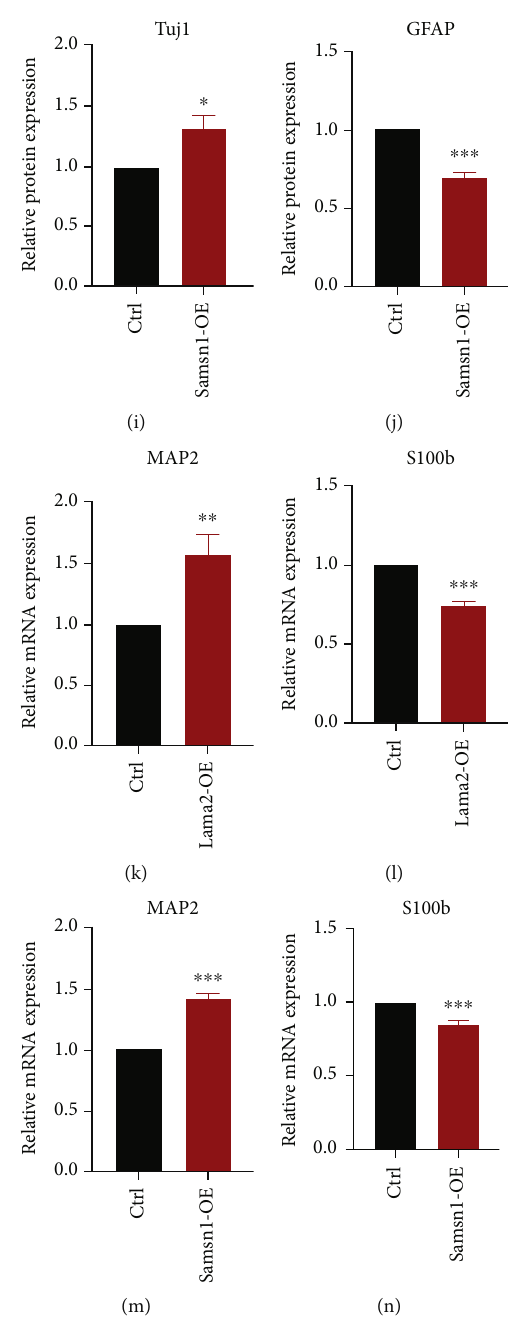
Figure 6: Lama2 activation or Samsn1 overexpression promotes NSCs di ff erentiation into neurons. (a, b) Representative immunostaining for Tuj1 (red) in the primary hippocampal NSCs after induced di ff erentiation for 7 days following plasmid transfection or lentivirus infection. Bar = 50 μ m . (c, d) Quanti fi cation of Tuj1-positive cells normalized to Hoechst. (e – j) Representative immunoblots of Tuj1, GFAP, and β -actin in the primary hippocampal NSCs after induced di ff erentiation for 7 days following plasmid transfection or lentivirus infection (e, f) and quanti fi cation of Tuj1 and GFAP protein levels normalized to β -actin (g – j). (k – n) Quanti fi cation of MAP2 and S100b mRNA levels normalized to β -actin after induced di ff erentiation for 7 days following plasmid transfection or lentivirus infection. Error bars represent the mean ± SEM . n = 3 . ∗ P < 0 : 05 , ∗∗ P < 0 : 01 , ∗∗∗ P < 0 : 001